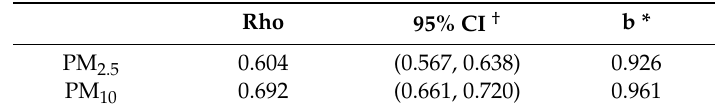
Table 4. Calculation of Lin’s concordance correlation coe ffi cient (Rho) to estimate agreement between Network and regulatory 24-h average PM 2.5 and PM 10